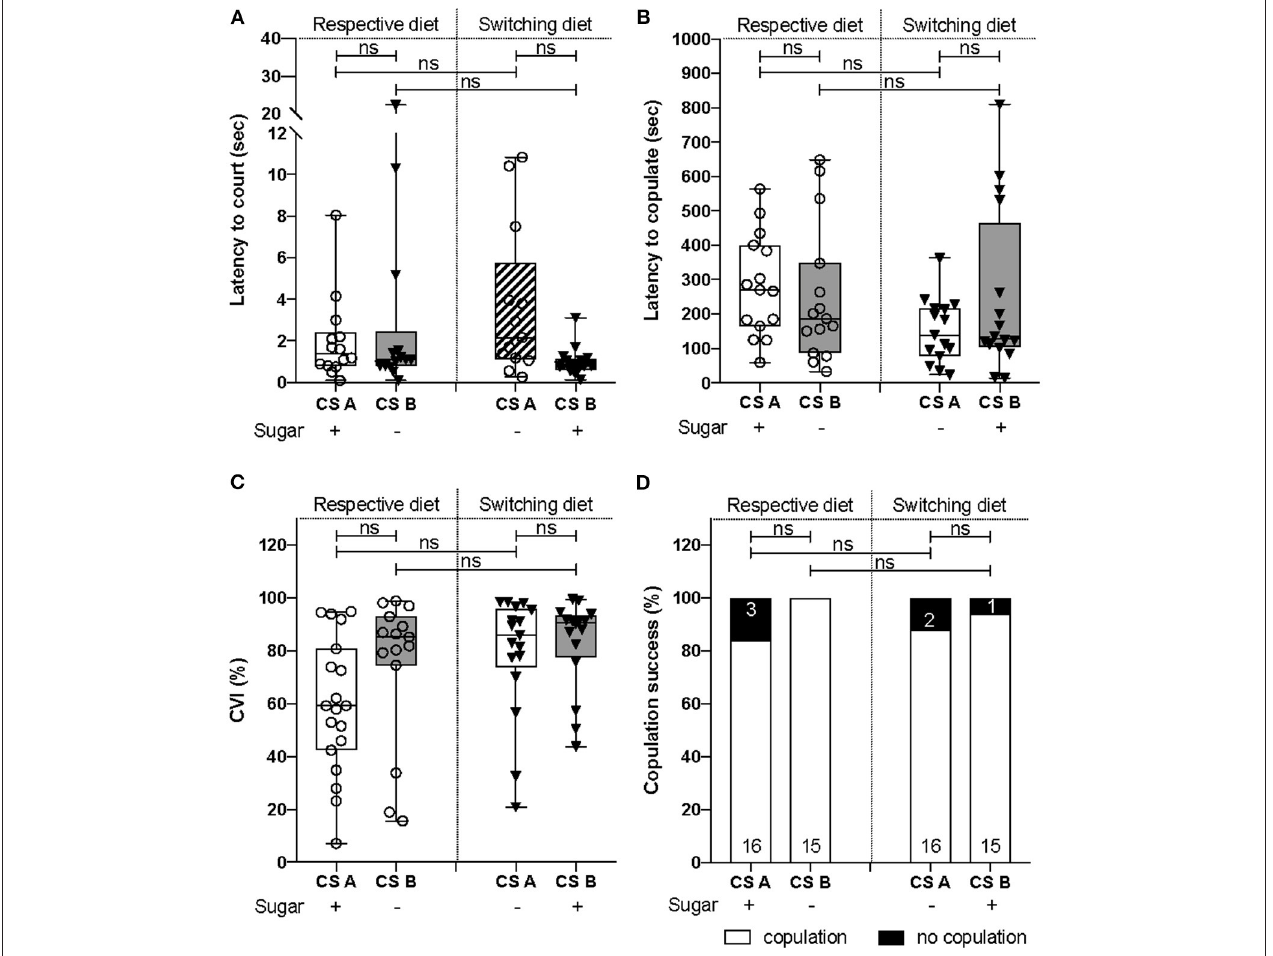
FIGURE 3 | Courtship abilities did not differ between both CS lines. (A) There was no difference in the latency to court between CS lines ( χ ² test = 1.2, d.f = 1, p = 0.3) and diets ( χ ² test = 0.4, d.f = 1, p = 0.6). (B) No difference were observed across CS lines ( χ ² test = 1.7, d.f = 1, p = 0.2) and diets ( χ ² test = 2.5, d.f = 1, p = 0.1) for the latency to copulate. (C) CS lines [ F (1, 64) = 1.94, p = 0.18) and diet [ F (1, 64) = 3.93, p = 0.052] did not influence CVI. (D) The copulation success did not vary according to the CS lines ( χ ² test = 2.67, d.f = 1, p = 0.1) nor the diets ( χ ² test = 0.53, d.f = 1, p =